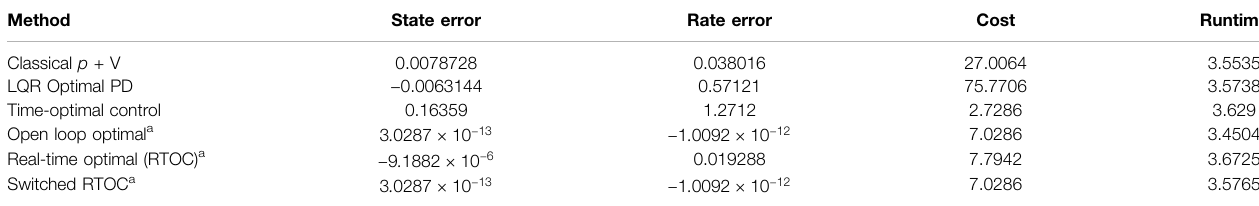
TABLE 11 | Double-integrator plant ( with transport theorem) with control design based off double-integrator with transport theorem: displays the quantitative comparative data corresponding to the qualitative display in Figures 5A, B